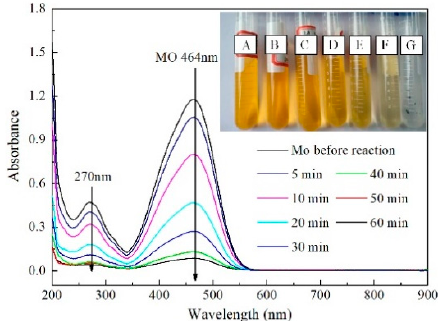
Figure 5. UV–vis patterns of degradation of MO.